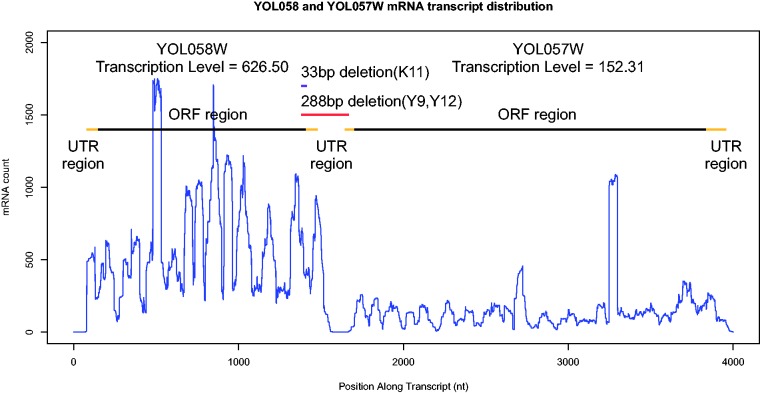
Transcription patterns do not support a gene fusion producing a single transcript. mRNA read counts from the Y12 strain S. cerevisiae (Skelly et al. 2013) were generated by sequence alignment using BFAST version 0.7a (Homer et al. 2009a, 2009b) and SAMtools version 0.1.19 (Li et al. 2009). ORF regions for YOL058W and YOL057W are shown by black bars. UTR regions (yellow bars) are based on the annotation of David et al. (2006) for the reference S. cerevisiae strain. The putative 288 bp deletion, which is expected to cause a fusion between two S. cerevisiae genes, is indicated by the red bar, whereas a smaller 33 bp deletion is indicated by the purple bar.